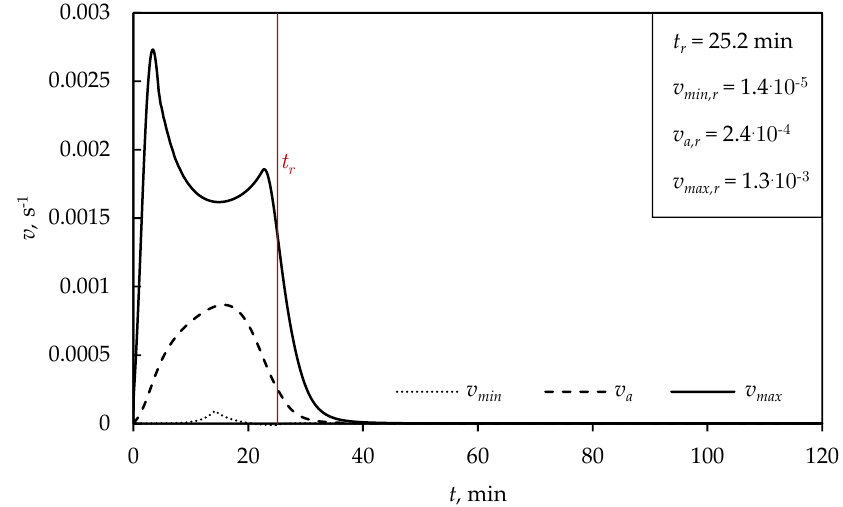
Figure 4. Dependence of vulcanization rate on time, for a sphere ( D = 5 cm) at T M = 150 °C.